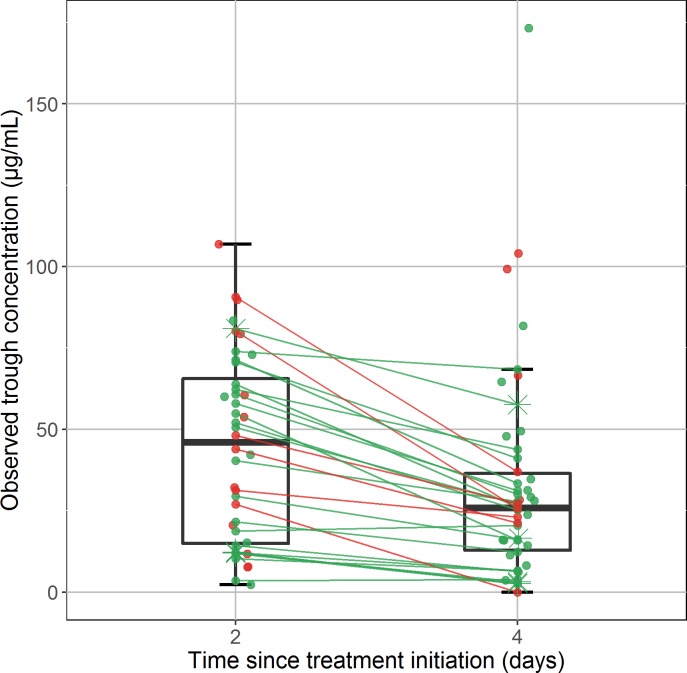
Observed trough concentrations of favipiravir at Day-2 (n = 44) and Day-4 (n = 50) after treatment initiation.Red points represent concentrations measured in patients who died during the trial, green points represent concentrations measured in those who survived. Concentrations obtained in patients receiving adult dose or weighted-based dose are presented in circles and stars, respectively. Lines connect data obtained in the 28 patients who had both measurements at Day-2 and Day-4. Boxplots represent the distribution of the concentrations. The lower and upper hinges correspond to the first and third quartiles. The upper whisker extends from the hinge to the highest value that is within 1.5 * IQR of the hinge, where IQR is the inter-quartile range, or distance between the first and third quartiles. The lower whisker extends from the hinge to the lowest value within 1.5 * IQR of the hinge.